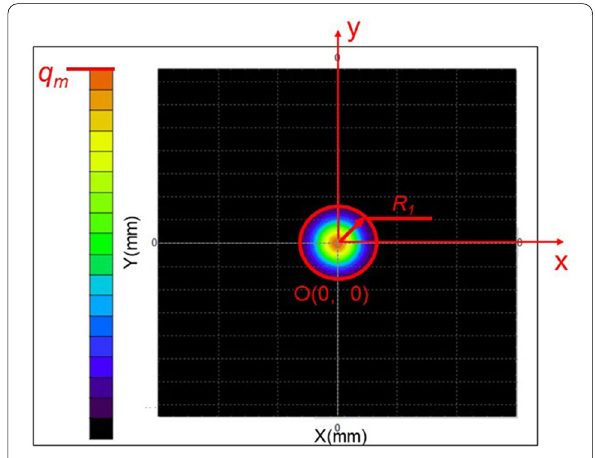
Figure 10 Power intensity contour image of three-beam laser at focal plane